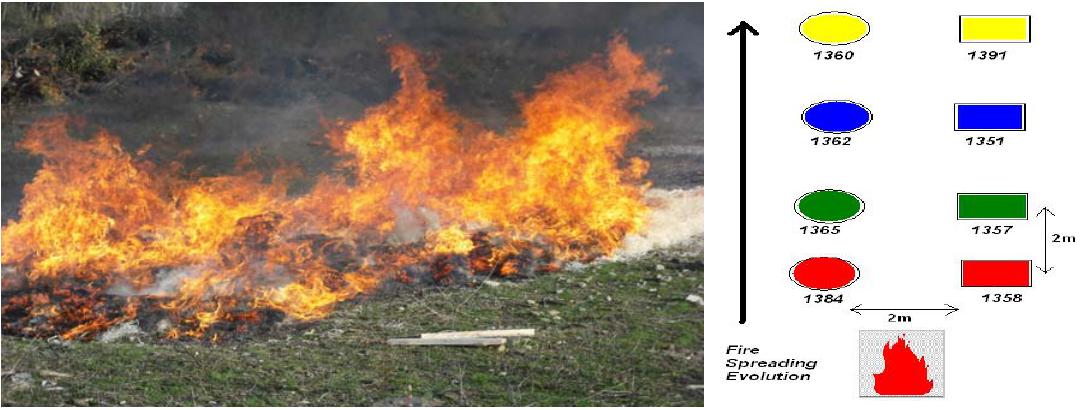
Figure 5. MICA 3 rd GEN Experimental Area with eight sensors on a square with 2 m in width and 2 m in distance between the